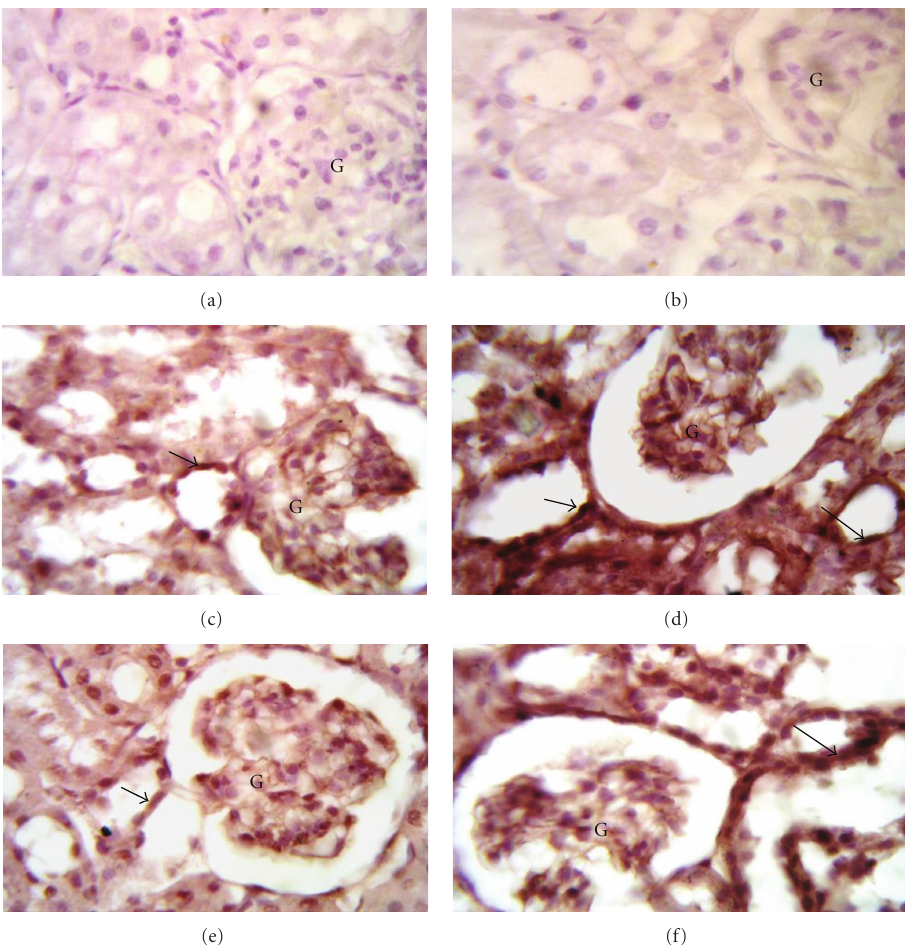
Figure 3: E ff ect of coenzyme Q10 (CoQ10) on caspase 3 immunohistochemical staining of doxorubicin- (Dox-) treated and untreated rat kidney. Localization of caspase 3 immunoreactivity in the kidney cortex ( × 1000) of ((a) and (b)) untreated control and low dose CoQ10 treated (CoQ10L) groups, respectively, showing negative immunoreactivity; (c) high dose CoQ10 treated group (CoQ10H) showing faint expression within the glomeruli (G) and the renal tubules (arrow); (d) Dox-treated group showing high expression in the renal glomeruli (G) and renal tubules. The expression is mainly cytoplasmic, but with some nuclei showing positive expression (arrows); (e) Dox/CoQ10L group showing faint expression within the glomeruli (G) and the renal tubules (arrow); (f) Dox/CoQ10H group showing high expression in the glomeruli (G) and the renal tubules